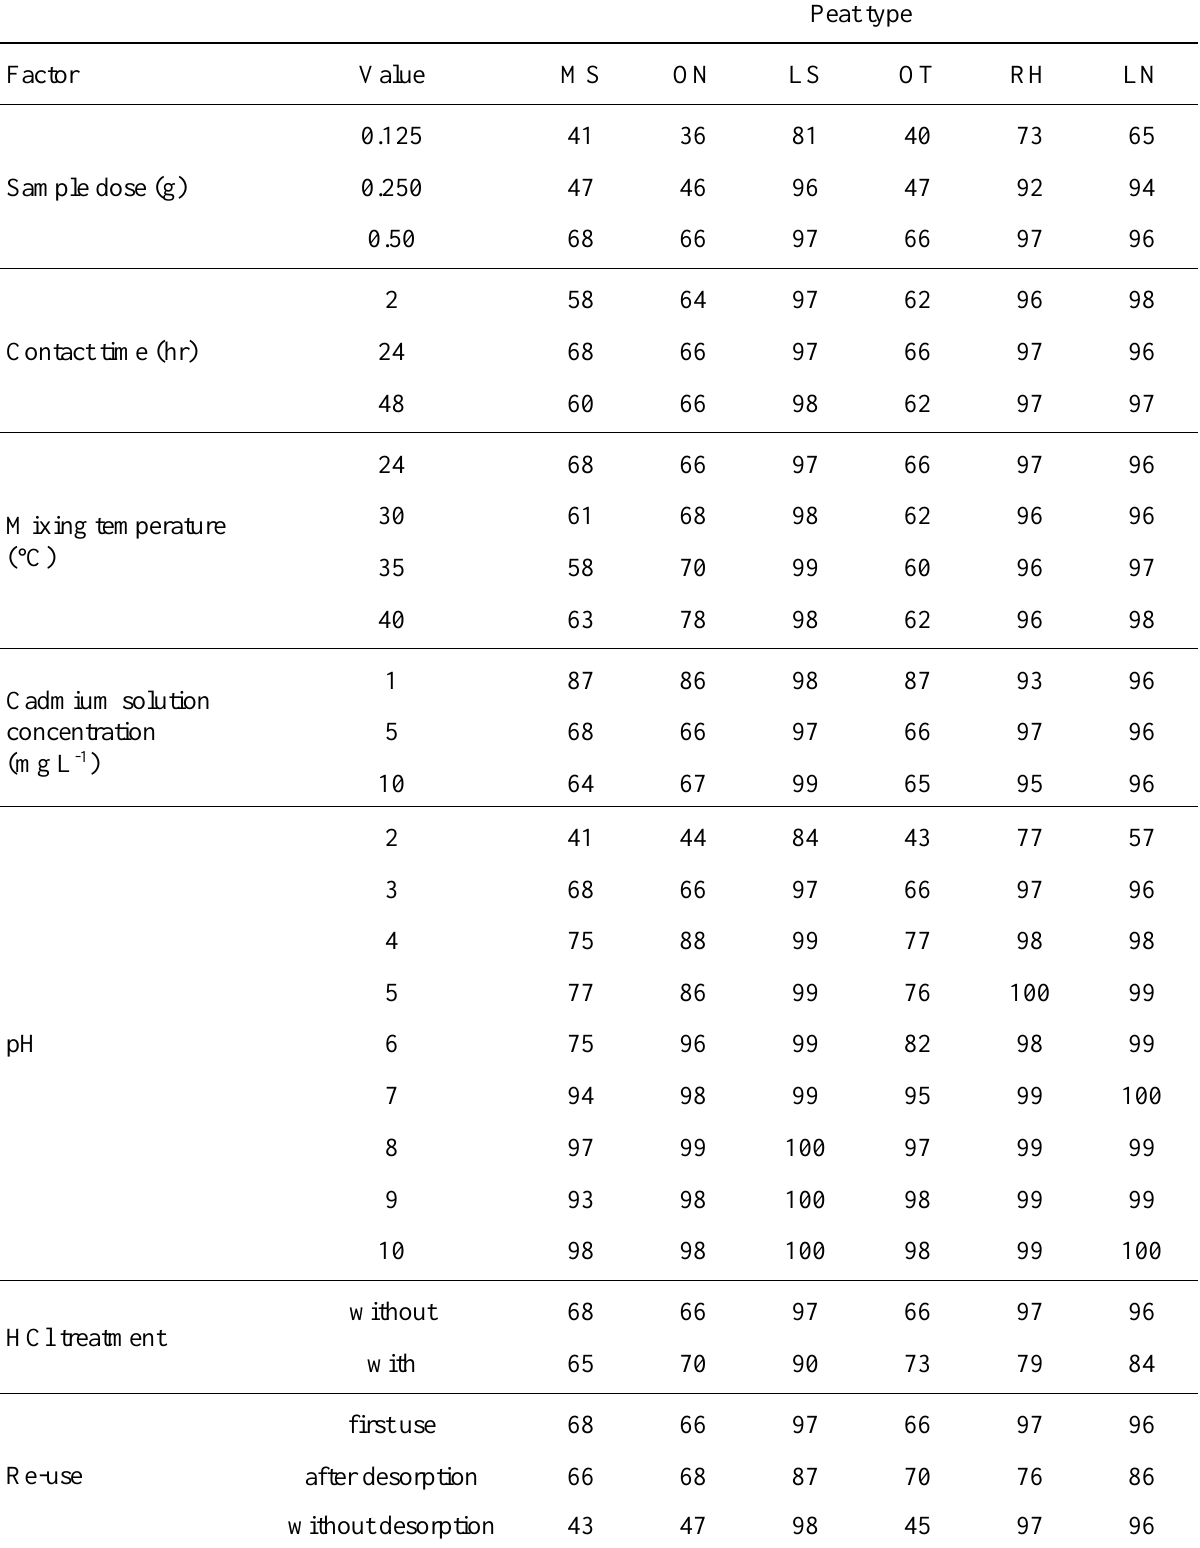
Table 1. Percent cadmium biosorption by each of the six peat types with variation of the factors that were